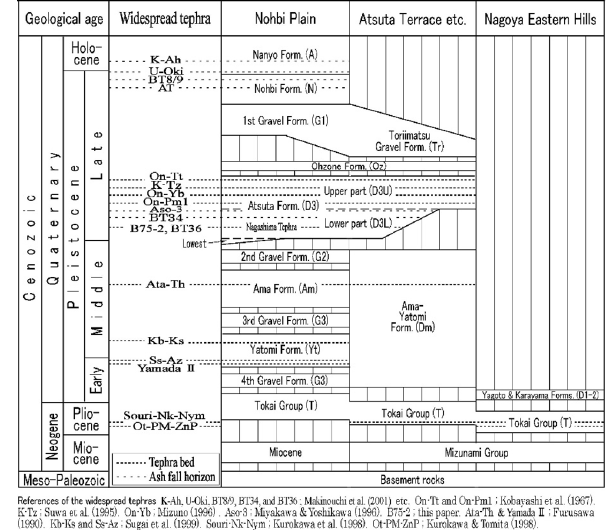
Figure 3. Subsurface stratigraphy of the Nohbi Plain and the sur- rounding areas (Makinouchi et al., 2013).